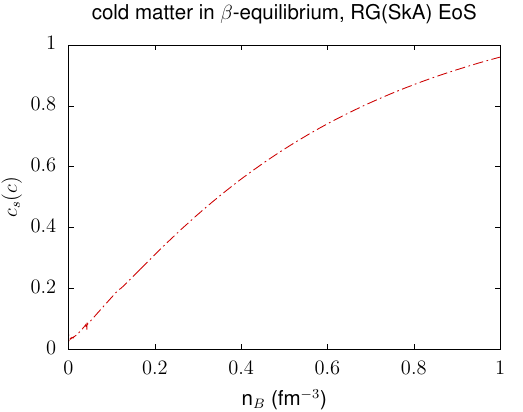
Figure 4. Sound speed as function of baryon number density for the cold β -equilibrated RG(SkA)